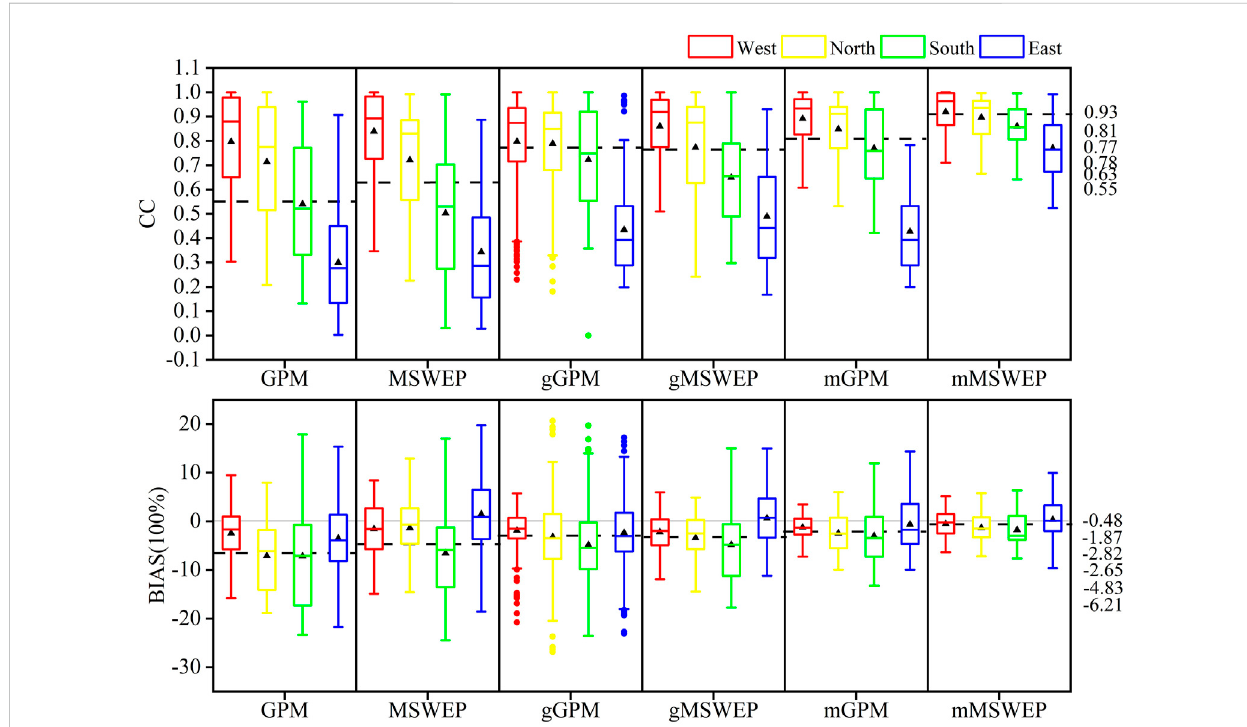
FIGURE 8 AccuracyevaluationofGPM,MSWEPandtheirdownscalingresultsindifferentsub-regions(Intheboxdiagram,thesolidlinerepresentsthemedian, theblacktrianglerepresentsthemean,thefourhorizontallinesfromtoptobottomarethetopedge,thetopquartile,thebottomquartileandthebottom edge respectively, and the round dot represents the